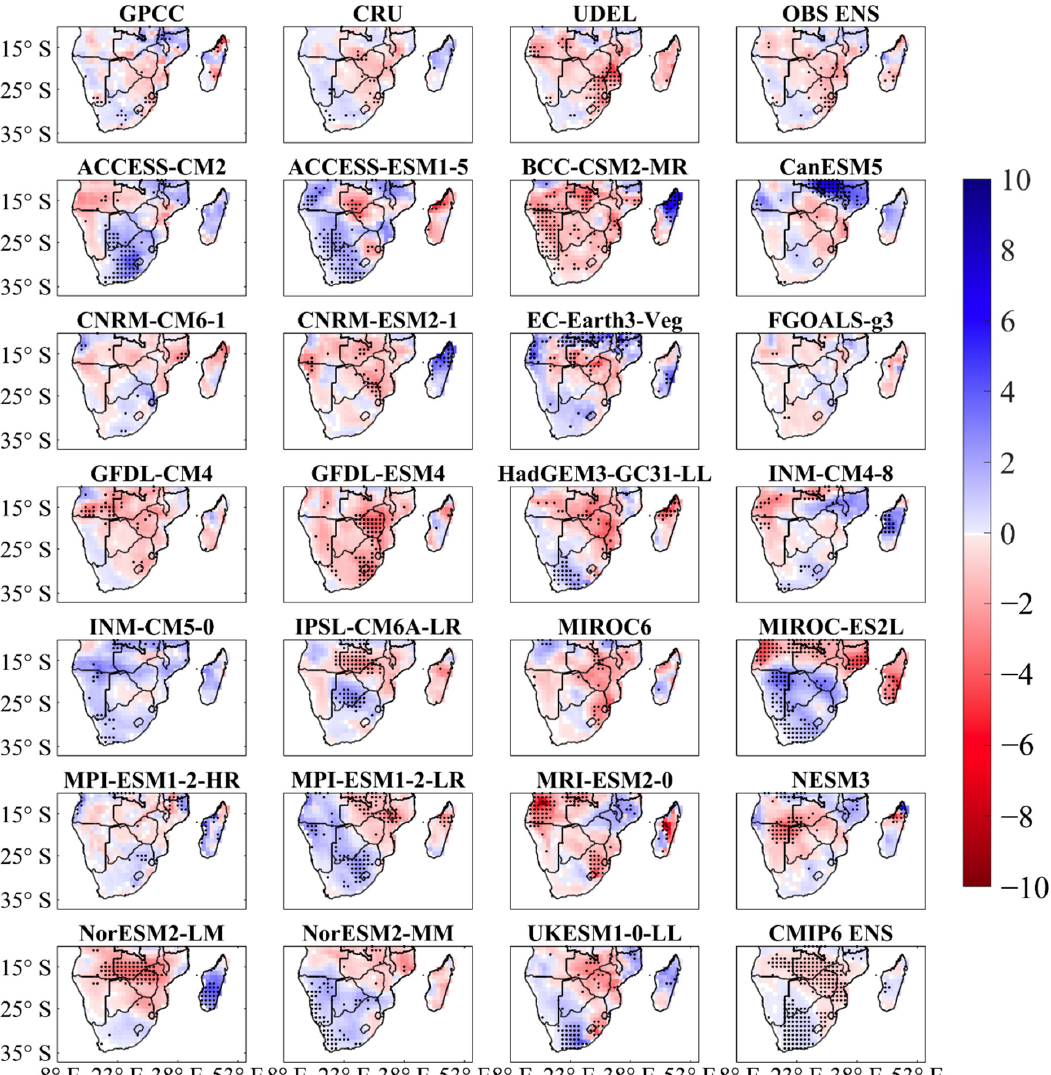
Figure 4. Spatial characteristics of DJFM precipitation trends (mm/decade) over Southern Africa from 1901 to 2014. Red and blue tones represent upward and downward trends, respectively. The first row shows trends from observation data. The black dots denote grids significant at a 95% confidence level.